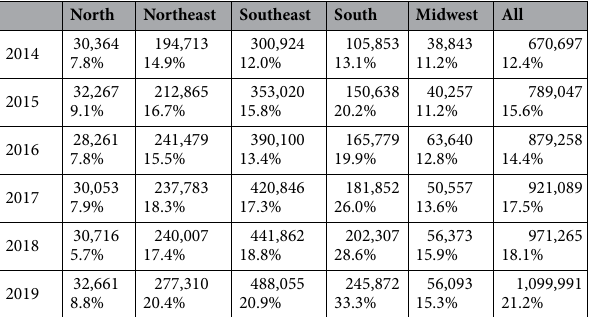
Table 1. Number of procedures and coverage of Diabetic Retinopathy Screening among Diabetic Patients through SUS from 2014 to 2019 according to the region. First row: Number of diabetic retinopathy screening procedures. Second row: Diabetic Retinopathy Screening Coverage.